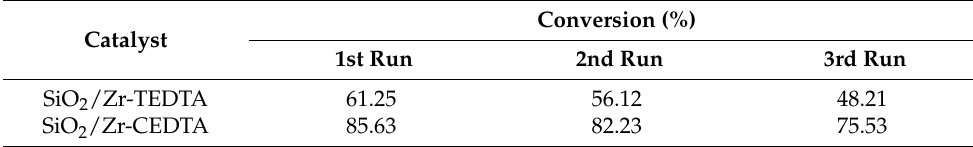
Table 6. Reusability study of SiO 2 /Zr-TEDTA and SiO 2 /Zr-CEDTA catalysts.